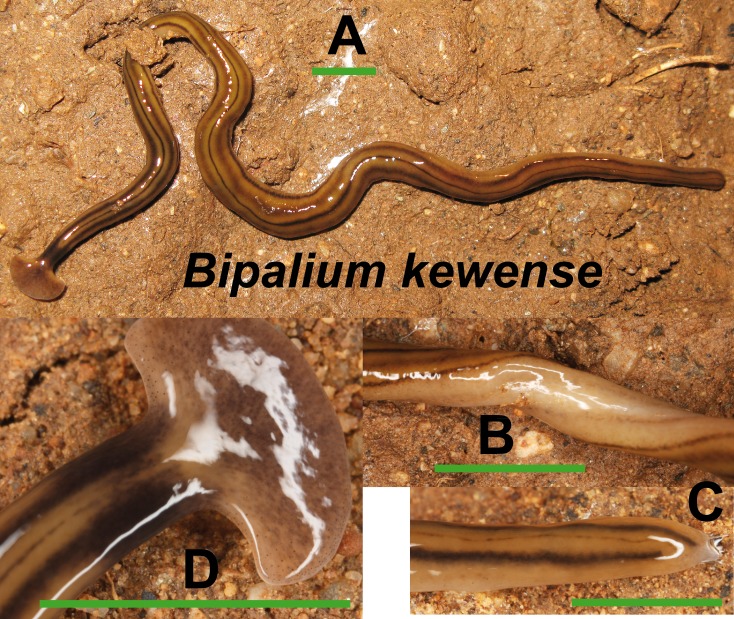
Bipalium kewense.(A) Dorsal view. (B) Ventral view of median part. (C) Dorsal view of posterior end. (D) Dorsal view of anterior end. Scale bar 5 mm.